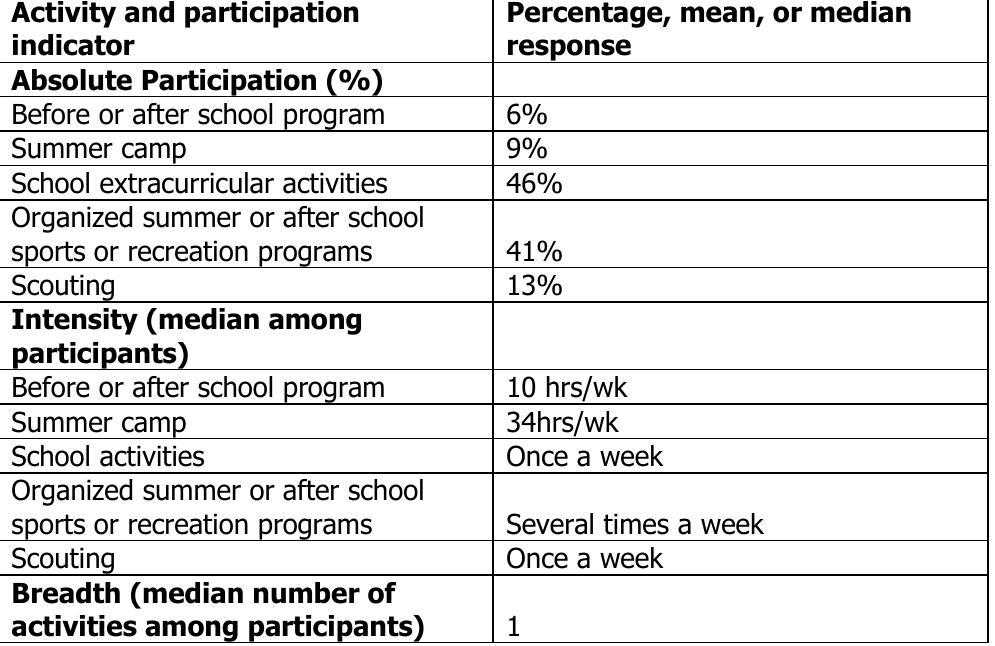
Percentages, means, and median responses on PSID OST participation indicators Activity and